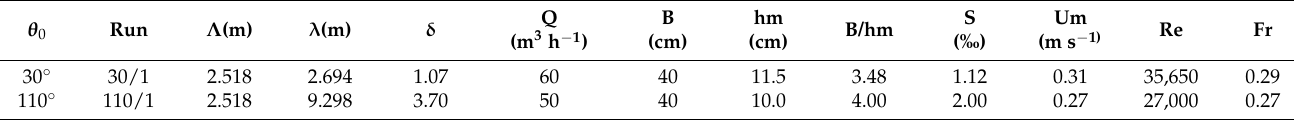
Figure 1. Experimental setup and the initial distribution of bed materials (unit: mm); inserts ( a ) and ( b ) are photos of the θ 0 = 30° and 110° flumes, respectively. Table 1. Flow and geometry characteristics of the two experiments.